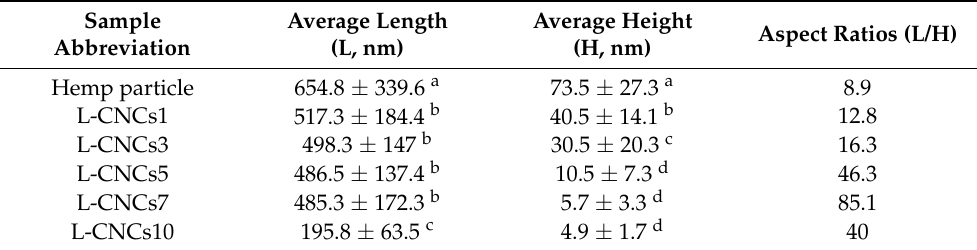
Table 2. List of morphological properties of hemp particle and